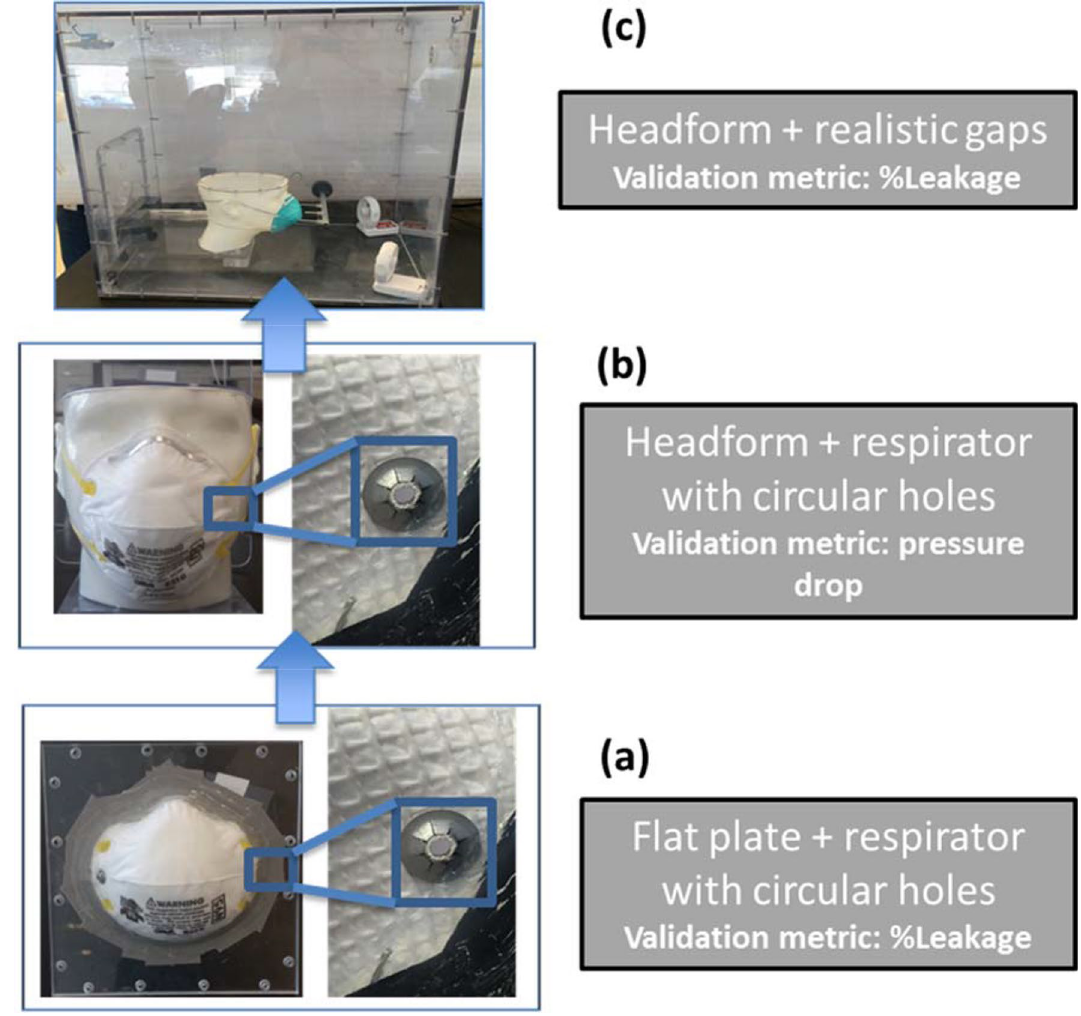
Figure 4. Validation